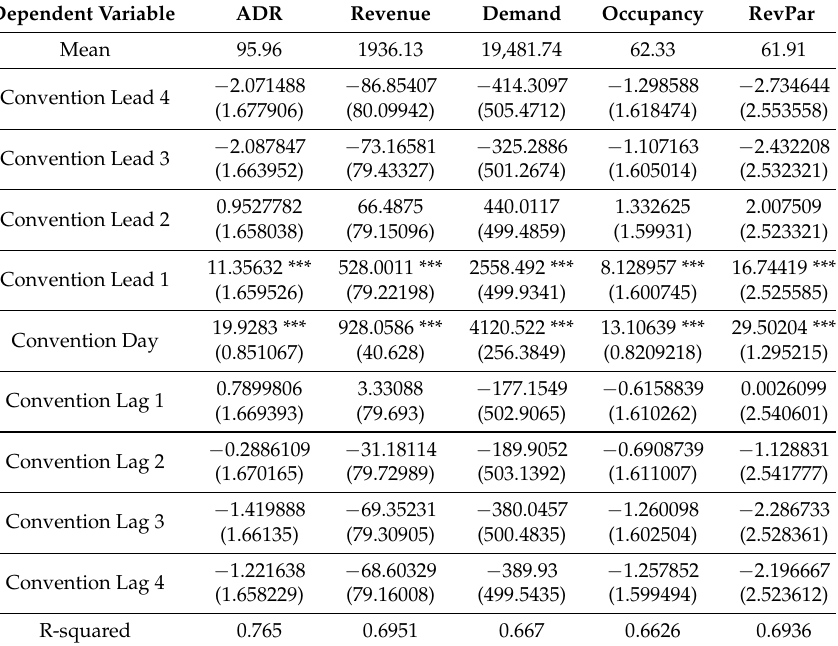
Table 5. The impact of Indianapolis area conventions on the hotel